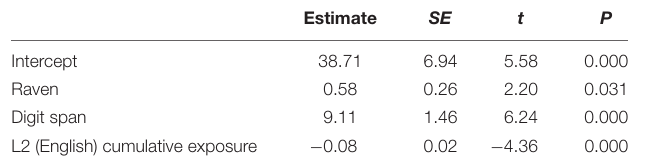
TABLE 5 | The best regression model predicting the productive grammar in the bilingual group.